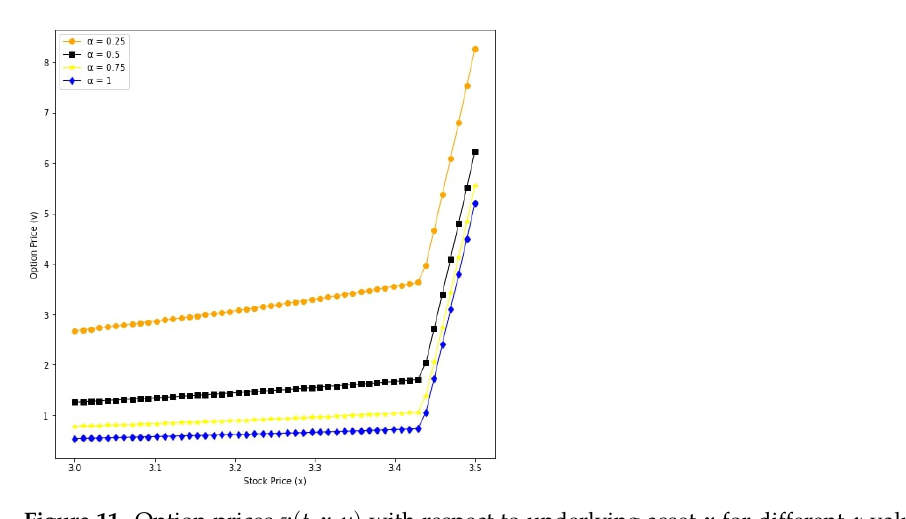
Figure 11. Option prices v ( t , x , y ) with respect to underlying asset x for different α values : v for y = 1.6093 and ρ = 1.